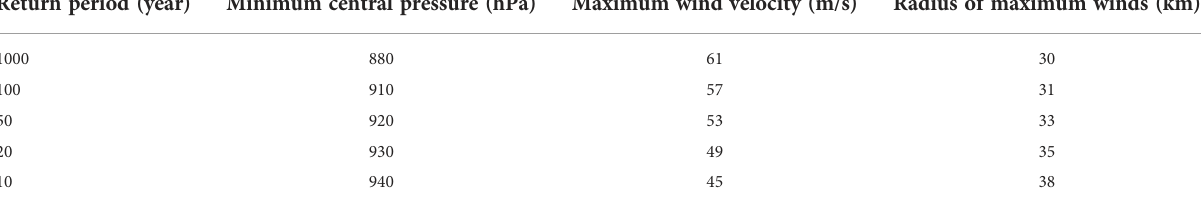
TABLE 1 Values of typhoon parameters for different hypothetical typhoon